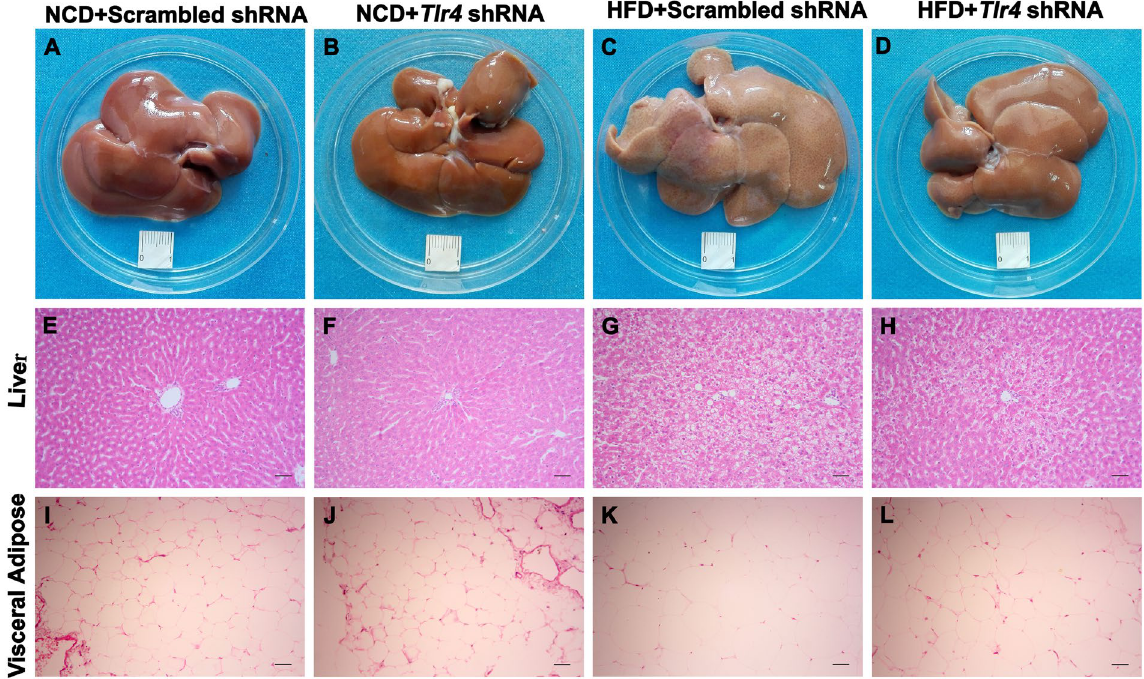
Figure 3. Down-regulation of Tlr4 mRNA expression in the hypothalamic ARC improves hepatic steatosis and adipocyte hypertrophy. ( A – D ) Macroscopic pictures of the livers of rats in each group indicated. Scale bar, 1 cm. ( E – H ) Histological analysis of liver stained with hematoxylin and eosin in the groups indicated. Scale bars, 100 μ m. ( I – L ) Histological analysis of visceral adipose stained with hematoxylin and eosin in the groups indicated. Scale bars, 100 μ m. NCD: normal chow diet group; HFD: high fat diet